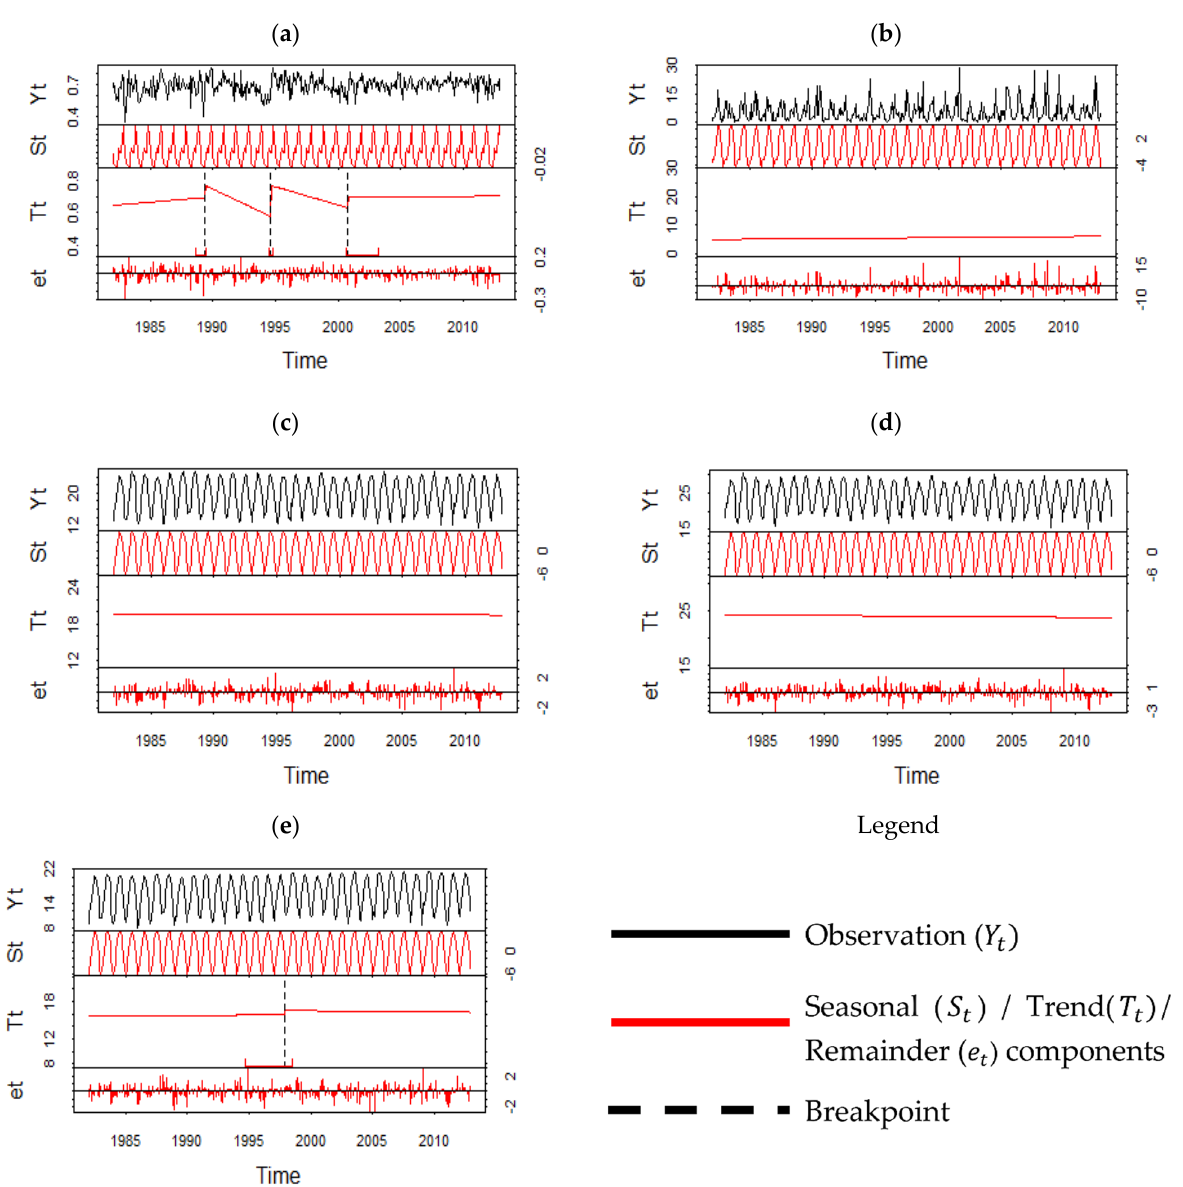
Figure 3. BFAST results for ( a ) NDVI, ( b ) rainfall (Rain), ( c ) average temperature (Avg-Temp), ( d ) maximum temperature (Max-Temp), and ( e ) minimum temperature (Min-Temp) in Taiwan. Table 2. BFAST breakpoints result for NDVI, rainfall (Rain), average temperature (Avg-Temp), maximum temperature (Max-Temp), and minimum temperature (Min-Temp) in Taiwan, with varied h values (shown in the detected year (month)). h NDVI